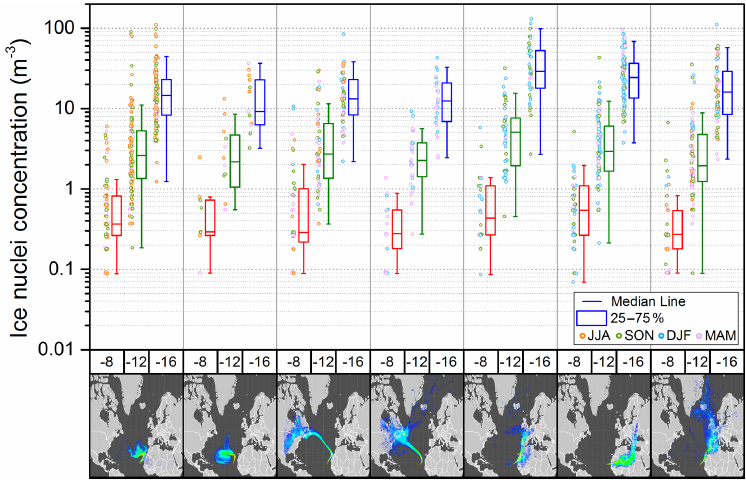
Figure 4. Variation of ice nuclei concentration classified into seven conditions of air mass origin at three temperatures. Data shown to the left of each box plot is color-coded by season (JJA: June–August; SON: September–November; DJF: December–February; MAM: March– May). Air mass classification from left to right: (1) African coastal, (2) Atlantic marine, (3) North American, marine and coastal, (4) North American and marine, (5) dust and European, (6) dust (e.g., Saharan and Sahel region) and (7) coastal and